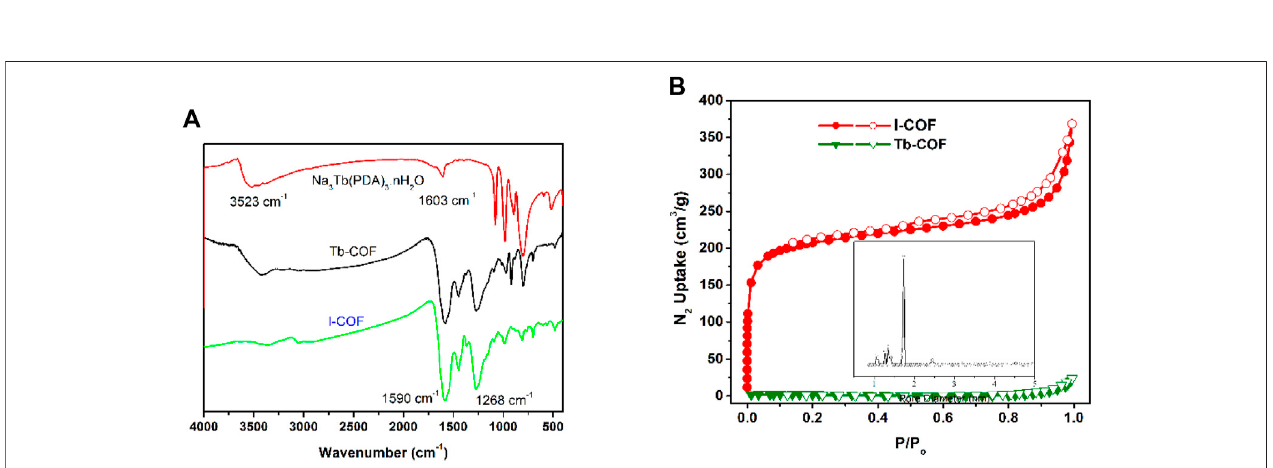
FIGURE3|(A) :IRspectraofI-COF,Tb-COF,andNa 3 Tb(PDA) 3 . (B) :N 2 adsorptionanddesorptionisothermsofI-COFandTb-COF.Inset:poresizedistributionof I-COF.